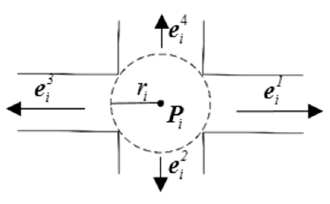
Figure 6. A decision point model with four directions.